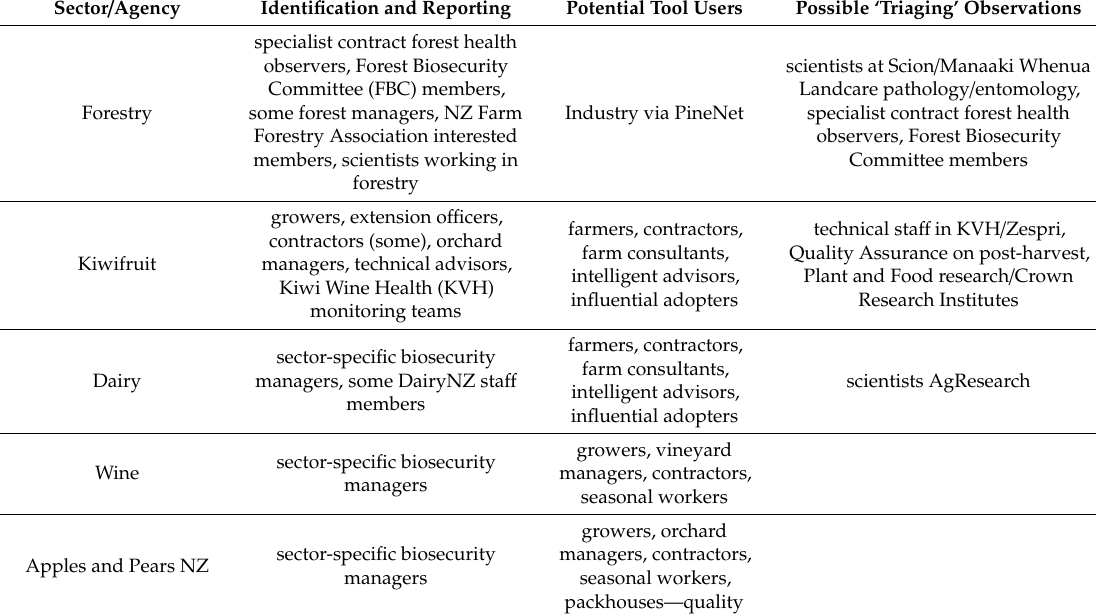
Table 3. Identification and reporting channels, potential users and possible ‘trusted advisors’ to identify / triage observations by sector. We didn’t have specific iwi participants to work with in this workshop as they were unable to attend on the day, and a separate process was followed through additional